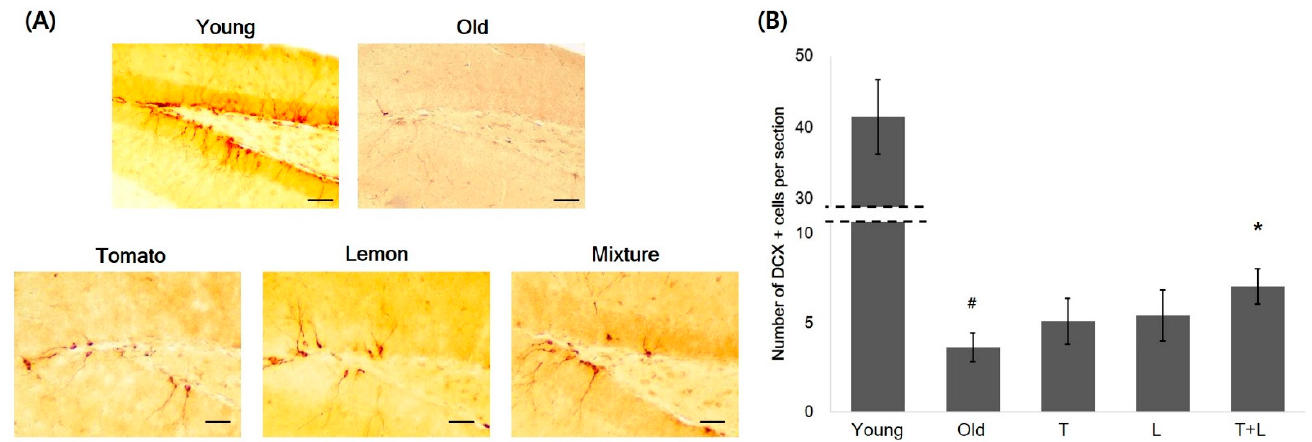
Figure 4. Increase of DCX-positive hippocampal neurons by oral administration of tomato, lemon and mixture extracts. ( A ) Representative images of DCX-positive neurons. Scale bars: young, old, tomato, lemon, mixture, 100 µ m. ( B ) The average DCX-positive cells per section was calculated and represented as a bar graph (n = 8 mice per group). The administration of mixture extracts showed synergistic increment of DCX-positive cells compared to old mice. # p < 0.01 vs. young mice. * p < 0.05 vs. old mice. T: tomato, L: lemon, T + L: mixture of tomato and lemon.